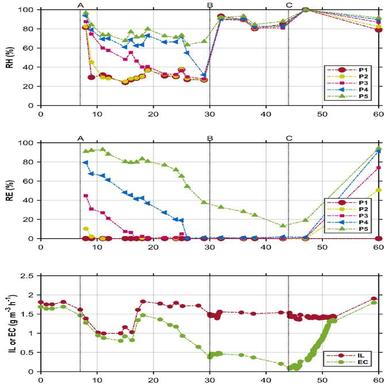
Evolution of RH (%), RE (%), IL and EC (g h1 m3 ) from day 1e60 of operation. Different perturbations were performed: (A) Disconnection of HS, (B) Reconnection of HS, (C) Addition of nutrients.